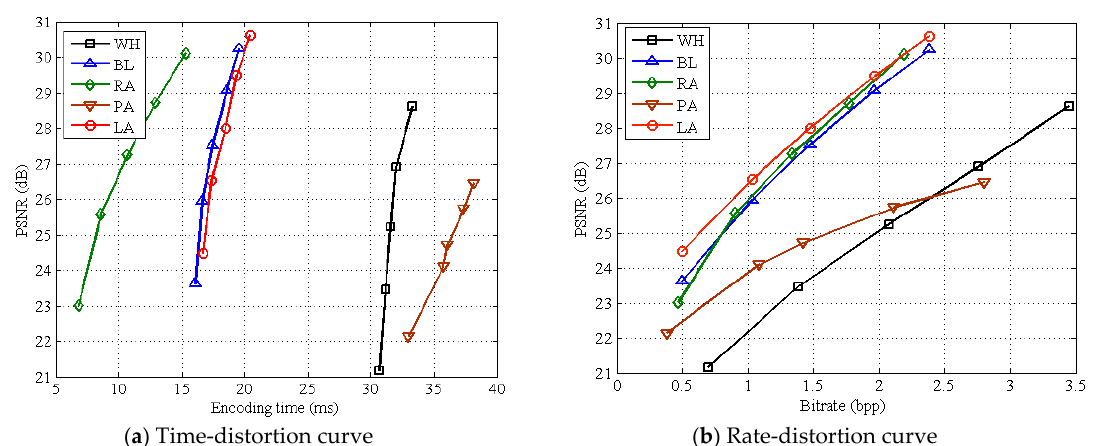
Figure 8. Average time-distortion and rate-distortion curves on test images for various measurement structures. Note: the block-size pair of LA is (8, 16).